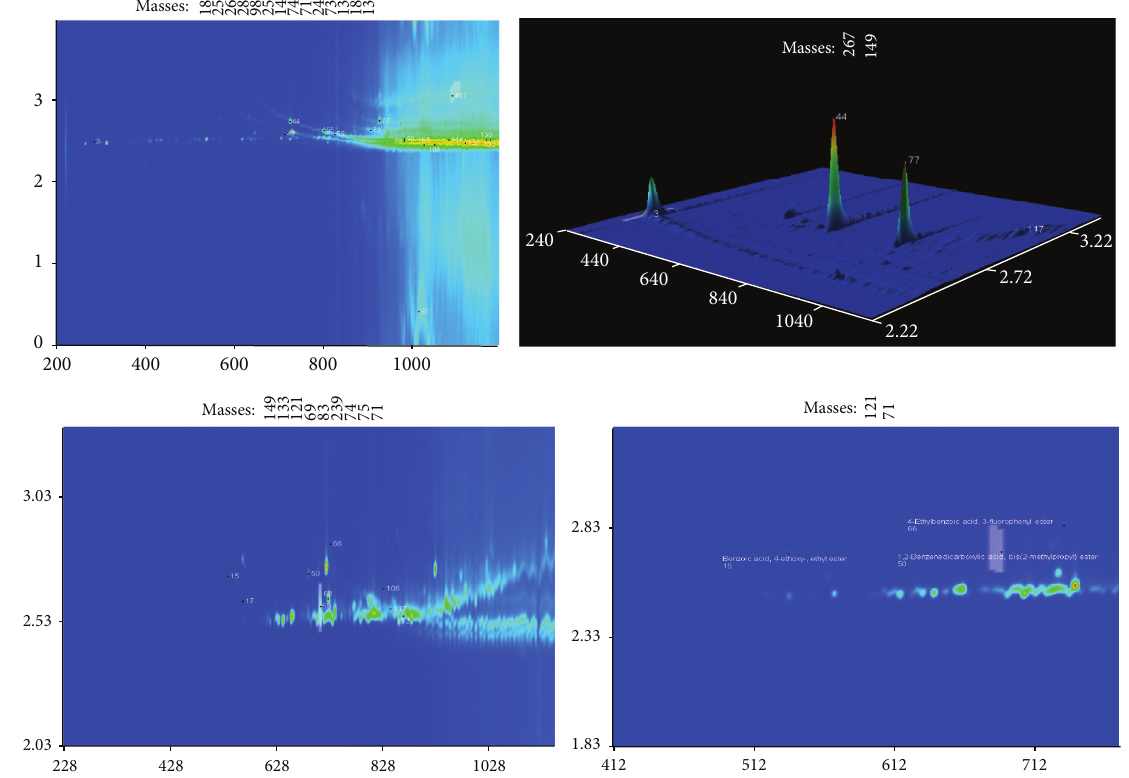
Figure 3: 2D chromatograms showing the compounds extracted in raw water using silica SPE and determined by using deconvolution ChromaTOF software in the GC × GC-TOFMS technique. Aromatic acids are shown as zoomed chromatograms to the right and indicated by arrows. The respective names, retention times, and GC-library similarities of selected carboxylic acids are tabulated (Table